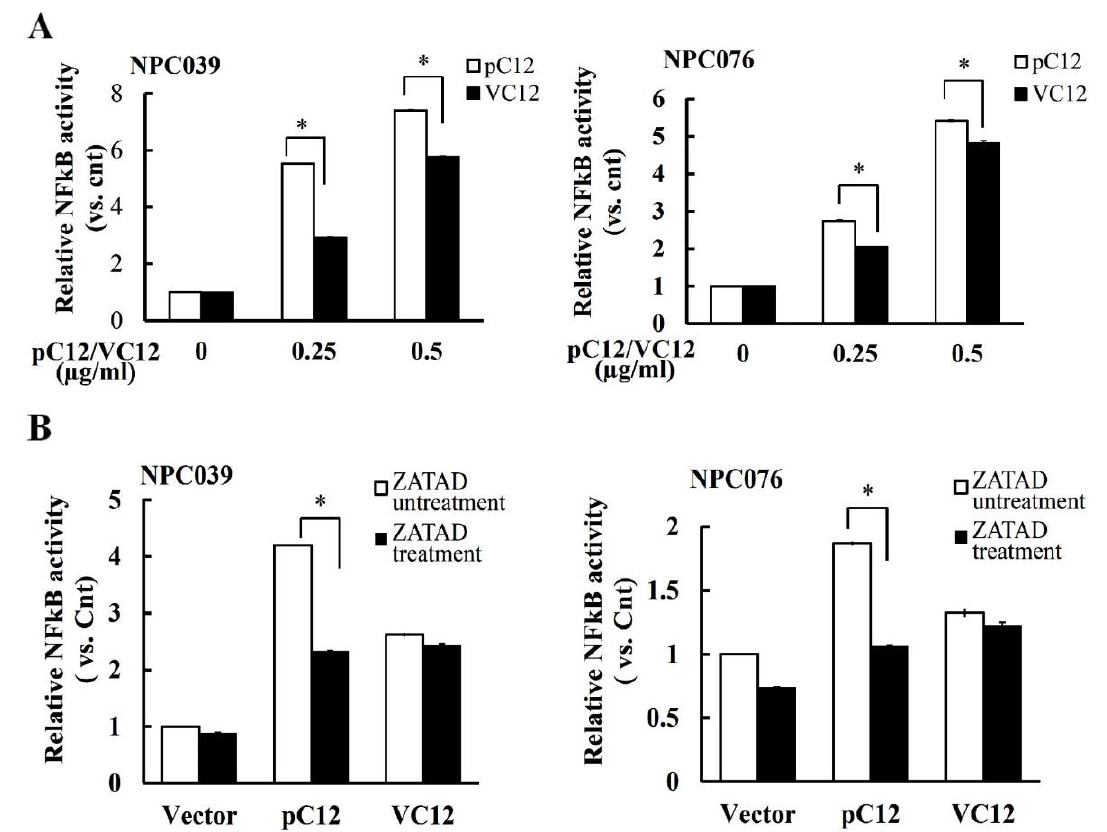
Figure 6. The active site of the hCasp12 in the regulation of NF- κ B. ( A ) NPC cells were transfected with pC12/VC12 (0~0.5 µ g/mL), ( B ) NPC cells were transfected with pC12/VC12 (0.5 µ g/mL), NF- κ B reporter/pSV- β -galactosidase plasmids in the presence of ATAD-fmk (3 µ g/mL) for 24 h. The transfected cell lysates were used to detect the luciferase activity. The data from three independent experiments are graphed as the mean ± s.e.m. ( n = 3), * p <